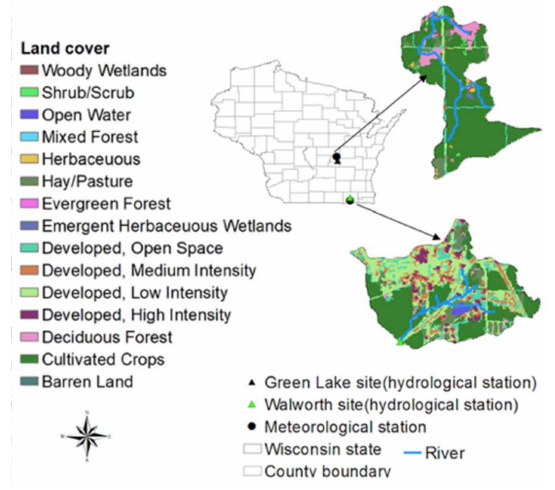
Figure 1. Drainage areas for the two sites in Wisconsin and the land uses of the two